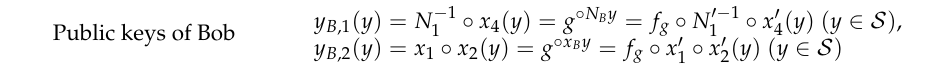
Table 6. Public keys of Bob for C SE . Public keys of